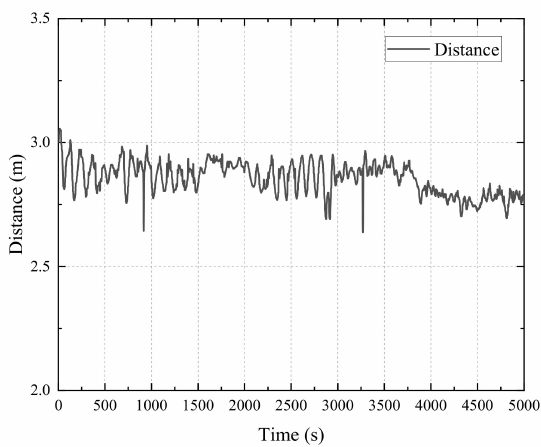
Figure 15. Distance from the wall during